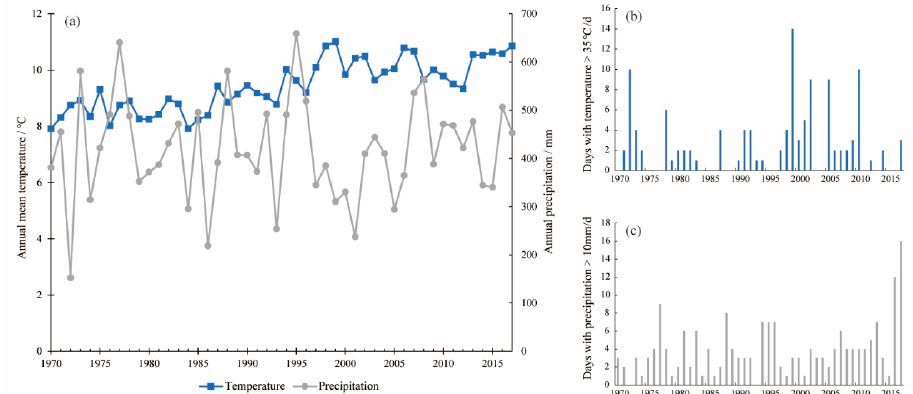
Figure 2. Variation of annual average temperature and annual precipitation ( a ), days with temperature above 35 °C ( b ), days with precipitation above 10 mm ( c ) in Yuanping from 1970 to 2017.